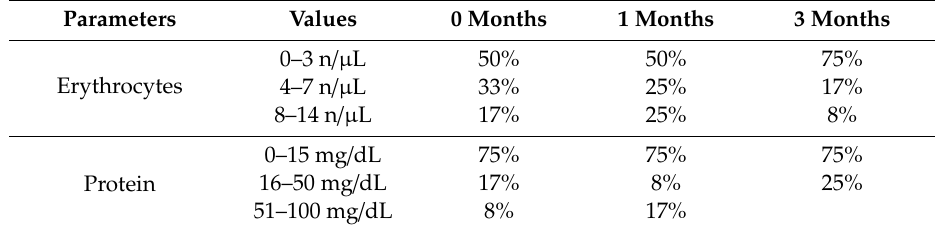
Table 3. Hematuria and proteinuria parameters. Percentage of hematuria and proteinuria in a group of 12 professional athletes.